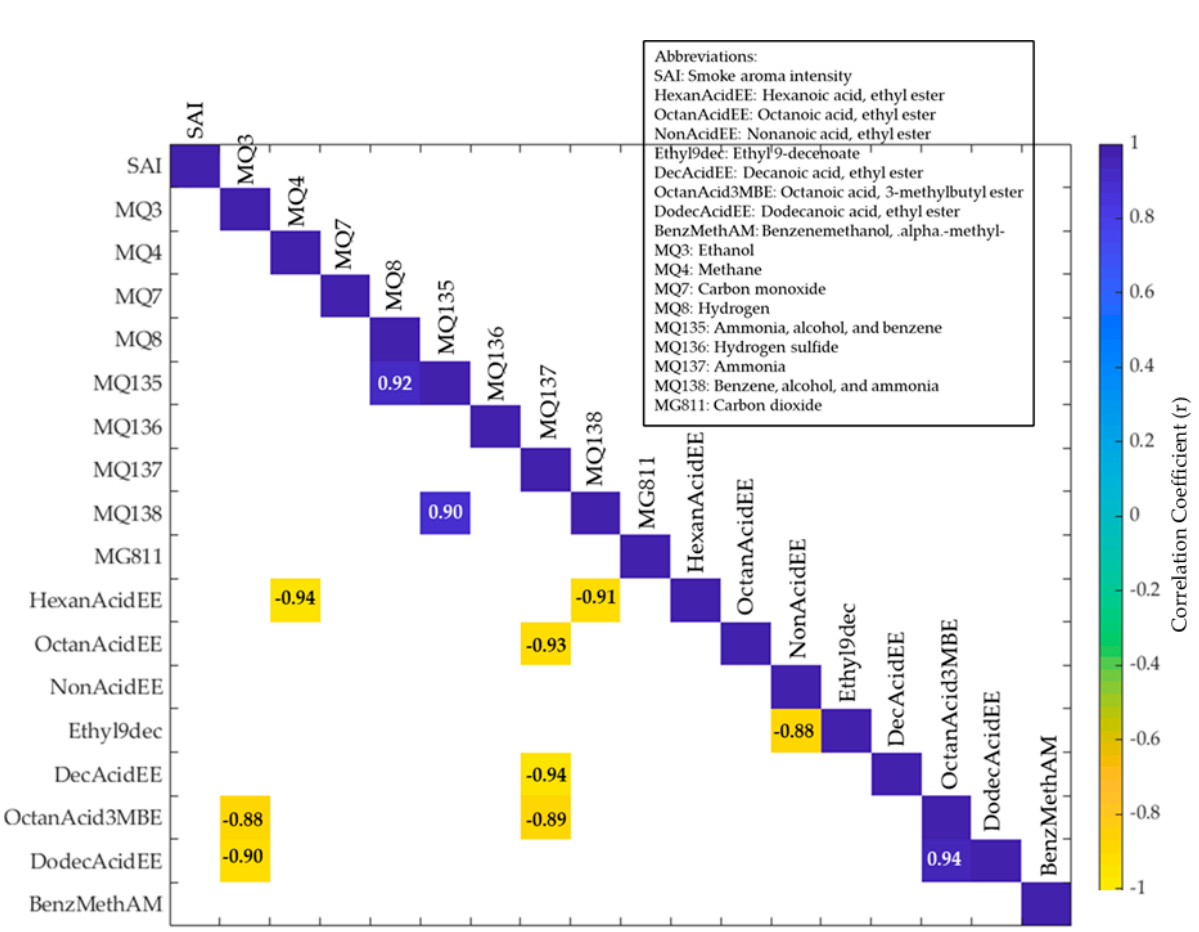
Table 2. Statistical results for the artificial neural network models developed to estimate the levels of volatile aroma compounds (Model 1) and smoke aroma intensity (Model 2) in wine, showing the correlation coefficient (R), determination coefficient (R 2 ), slope (b), and performance based on mean squared error (MSE) for each stage.